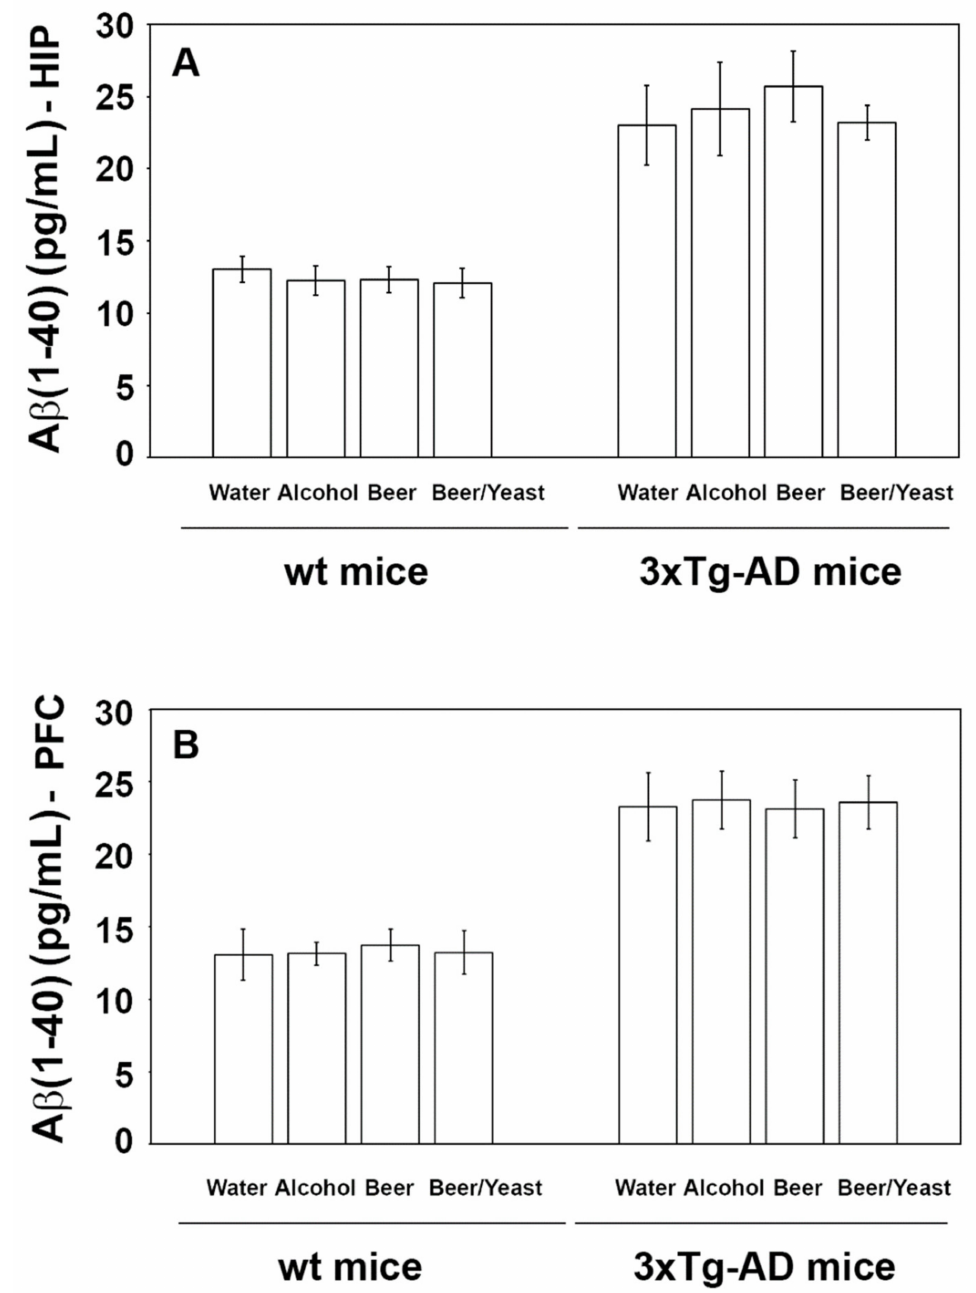
Figure 2. Levels of the A β (1-40) peptide measured by ELISA on brain homogenates of the wt and the 3xTg-AD mice treated with water, alcohol, beer and beer/yeast. Treatments did not affect the level of A β (1-40) in the HIP (panel A ) and PFC (panel B ) of the wt mice and 3xTg-AD mice. Data are expressed as pg/mL of A β